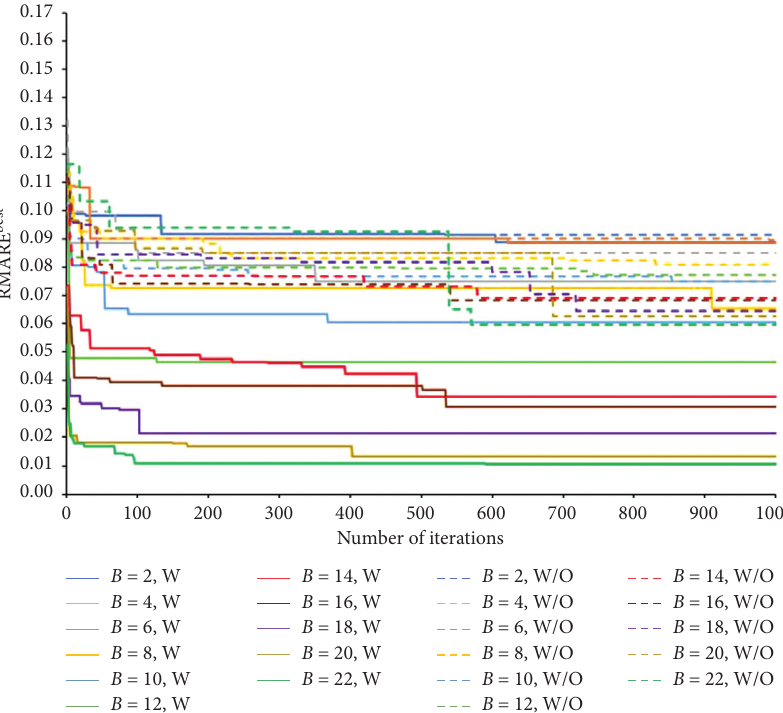
Figure 9: Evolution of RMARE best with the number of iterations considering different values of B with (W) or without (W/O) the proposed model. Table 8: Number of routes that appear with the application of the proposed algorithm according to the B value. B Number of routes in set R Number of routes in set Q Added routes with SL Number of routes in